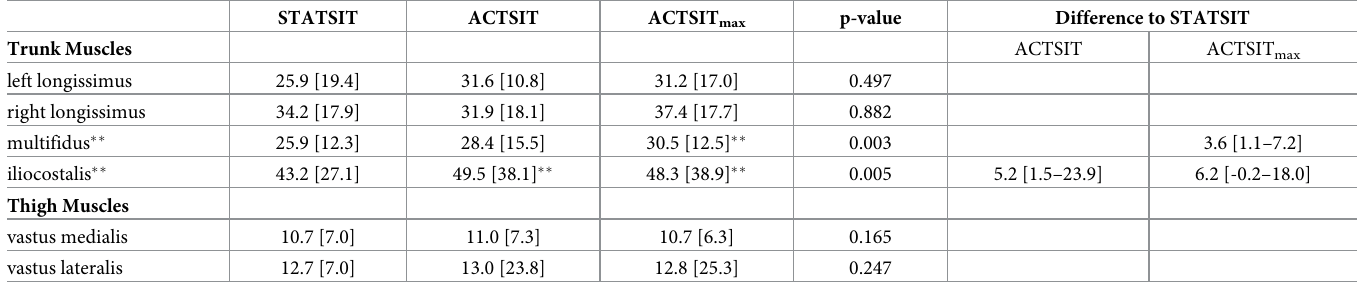
The kinematic comparison between ACTSIT and ACTSIT the seat RoM significantly affected all the investigated RoMs, except thorax inclination. Since Table 2. Average muscular